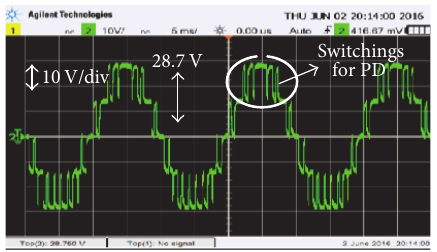
Figure 9: Output phase voltage waveform for PD modulation.